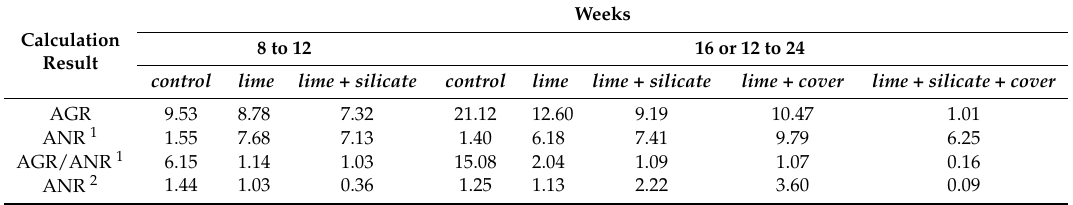
Table 5. ANR and AGR (mmol H 2 SO 4 week − 1 ) calculated using the concentration of cations and S in leachates during different periods of